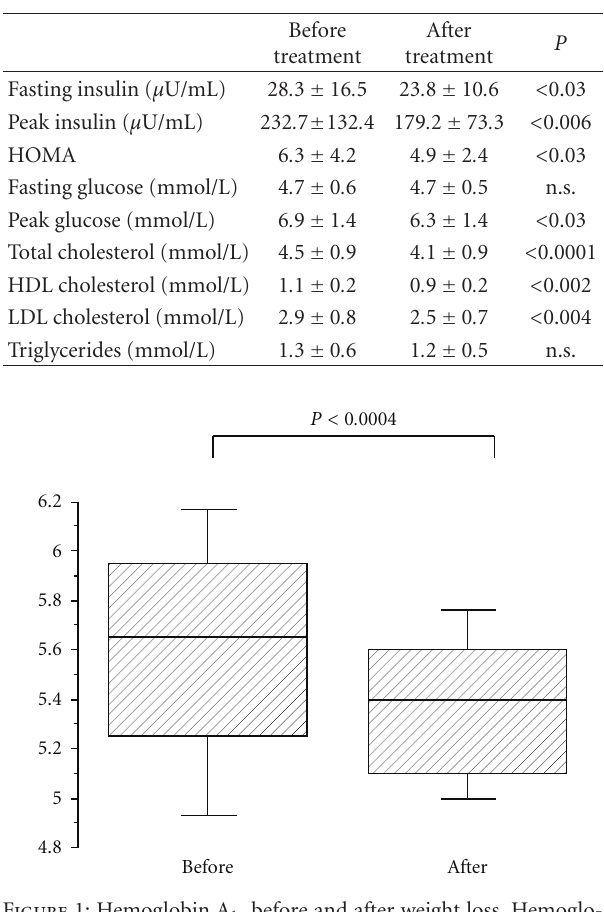
Table 2: Metabolic characteristics before and after participation in the obesity intervention program. Data are shown as means ± SD.